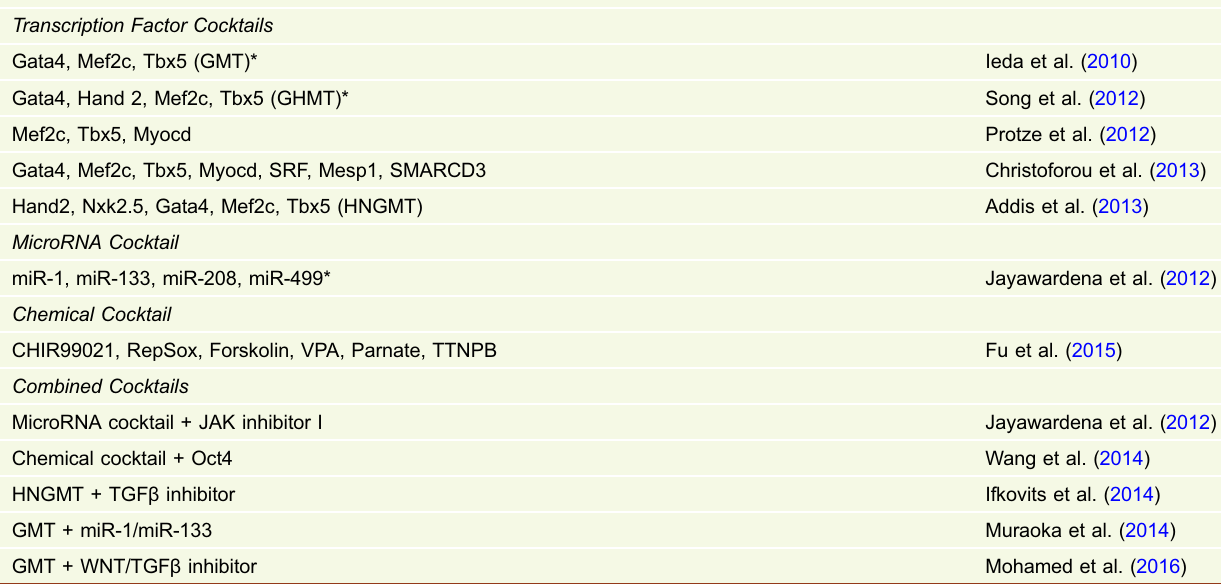
Table 1. Cocktails for direct cardiac reprogramming of mouse fi broblasts in vitro and in vivo (*)